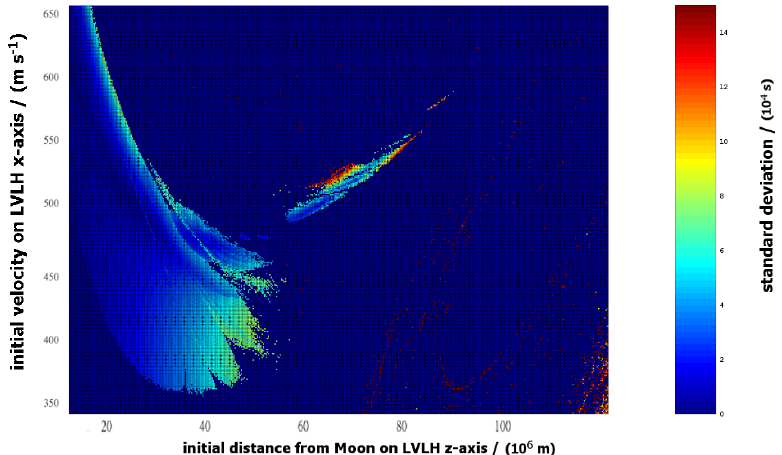
Figure 16. The standard deviation of the orbital period (color-axis) as a function of the initial state. As with Figure 15, the horizontal axis represents initial position (m) on the z -axis of the LVLH frame and the vertical axis represents the initial velocity (m · s − 1 ) along the x -axis of the LVLH